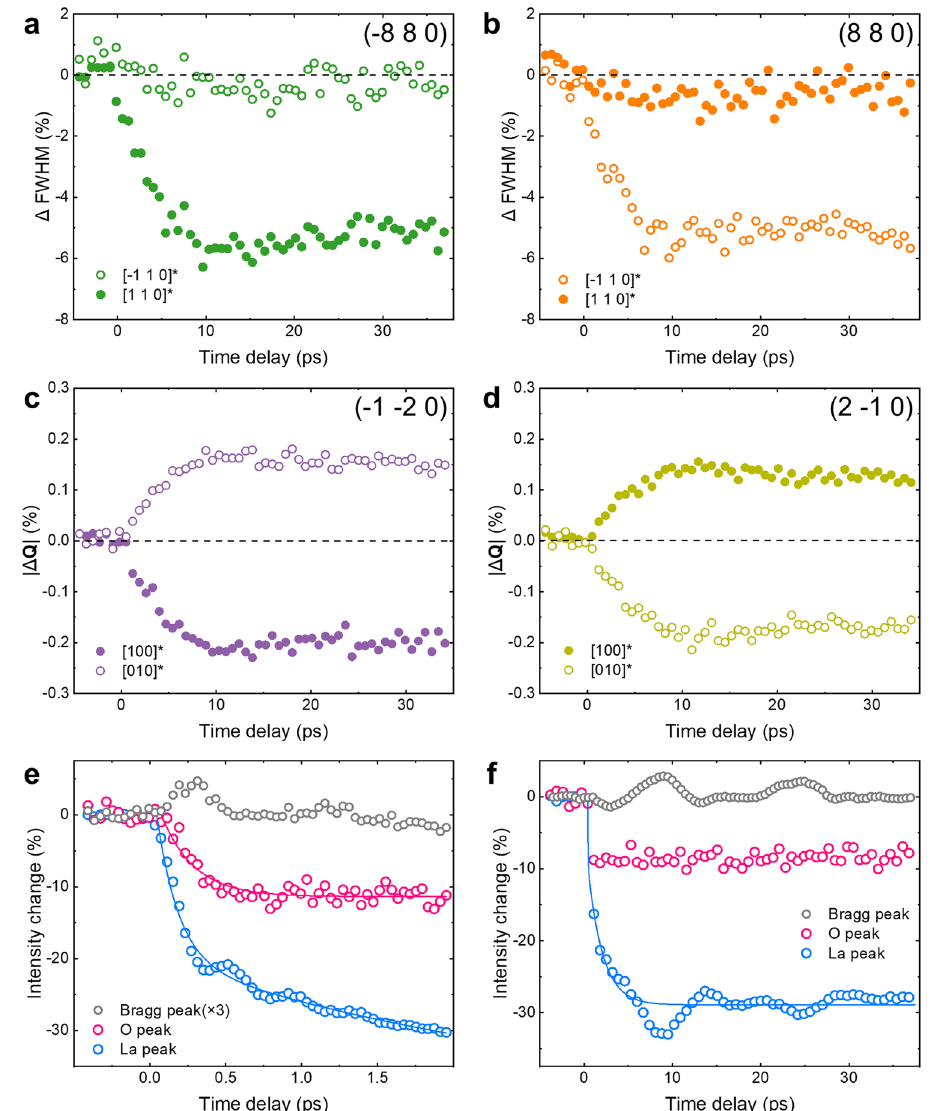
Fig. 3 Diffraction peak widths (FWHM) and intensity as a function of time delay. a , b The change of FWHM of the ( − 880) and (880) Bragg peaks measured along the [110]* and [ − 110]* directions. c , d The change of ǀ Δ Q ǀ along the [100] * and [010] * directions for ( − 1 − 20) ( c ) and (2 − 10) ( d ). e Bragg peaks (gray circles) and superlattice peaks induced by the MnO displacements (blue, La peak). f Intensity evolution of the Bragg peaks, O peaks and La peaks on a long timescale. The indices in ( e ) and ( f ) are (6 6 0), (1 2 0), and (3 5 0) for the Bragg peak, La peak and oxygen peak, respectively. ( e ) and ( f ) solid lines represent the exponential fi ts discussed in the main ferromagnetism and metallicity. Figure 4a shows the optimized structure (Labeled as Struct 1) using lattice constant obtained from the UED simulation (7.876 Å for the two ‘ − ’ rotation axes and 7.772 Å for the ‘ + ’ rotation axis). The rotation angles are 7.5° for the ‘ − ’ axes and 6.0° for the ‘ + ’ axis, similar to those used in the simulation at t = 0 ps. We further model three structures that represent three characteristic cells with reduced orthorhombicity. The rotation angles and Jahn – Teller distortion ( Q 2 , Q 3 ) are